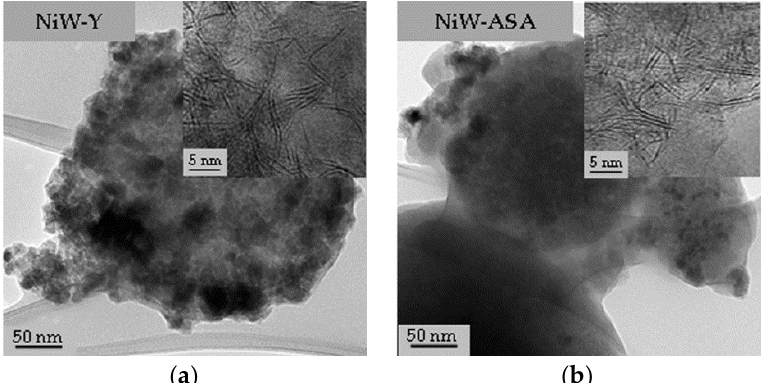
Figure 3. TEM micrographs of the catalysts prepared with the aluminosilicate additives ( а ) Y and ( b ) ASA (390 °C, 5.0 MPa, 5 h).